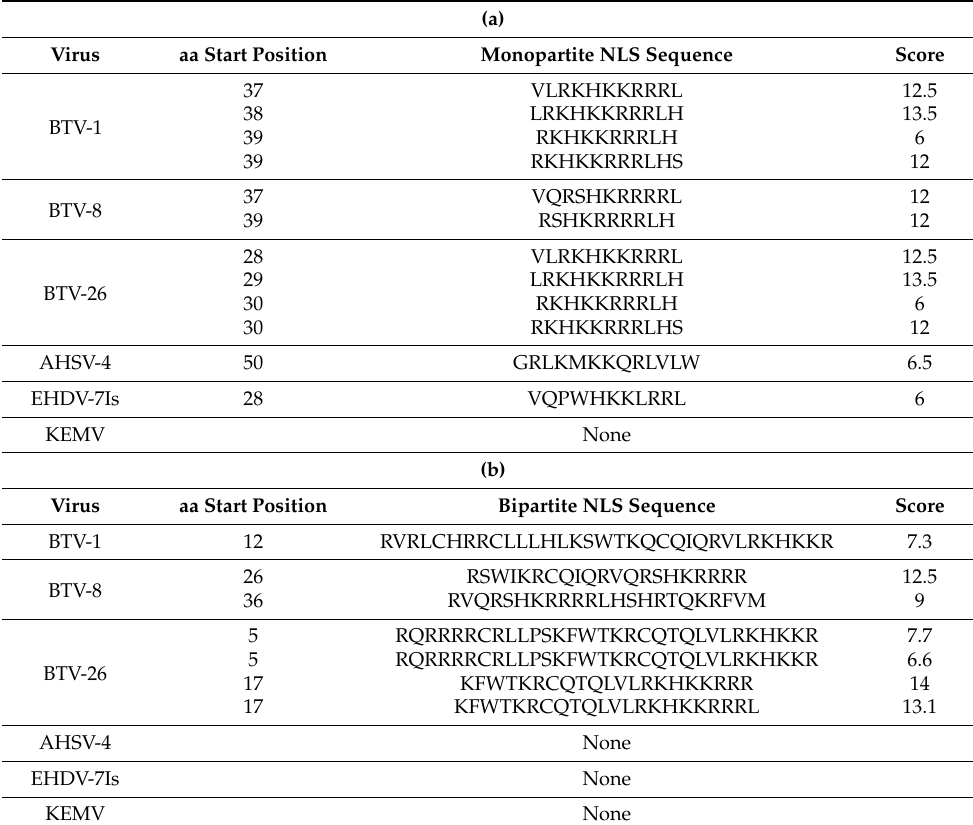
Table 1. The programme cNLS Mapper [29] was used to predict monopartite (a) and bipartite (b) nuclear localisation signals (NLS) in the amino acid (aa) sequences of NS5.